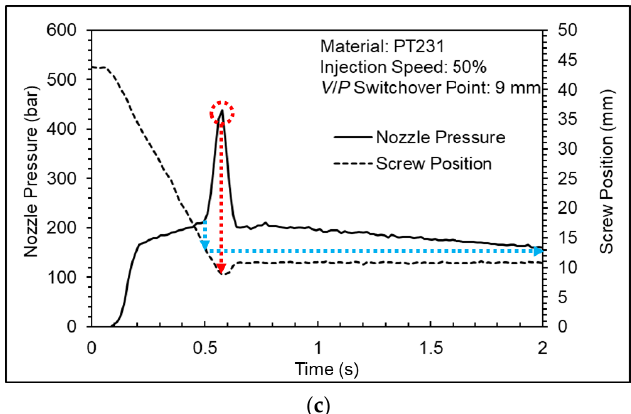
Figure 10. Nozzle pressure profile and screw position profile at the overfilling V/P switchover point